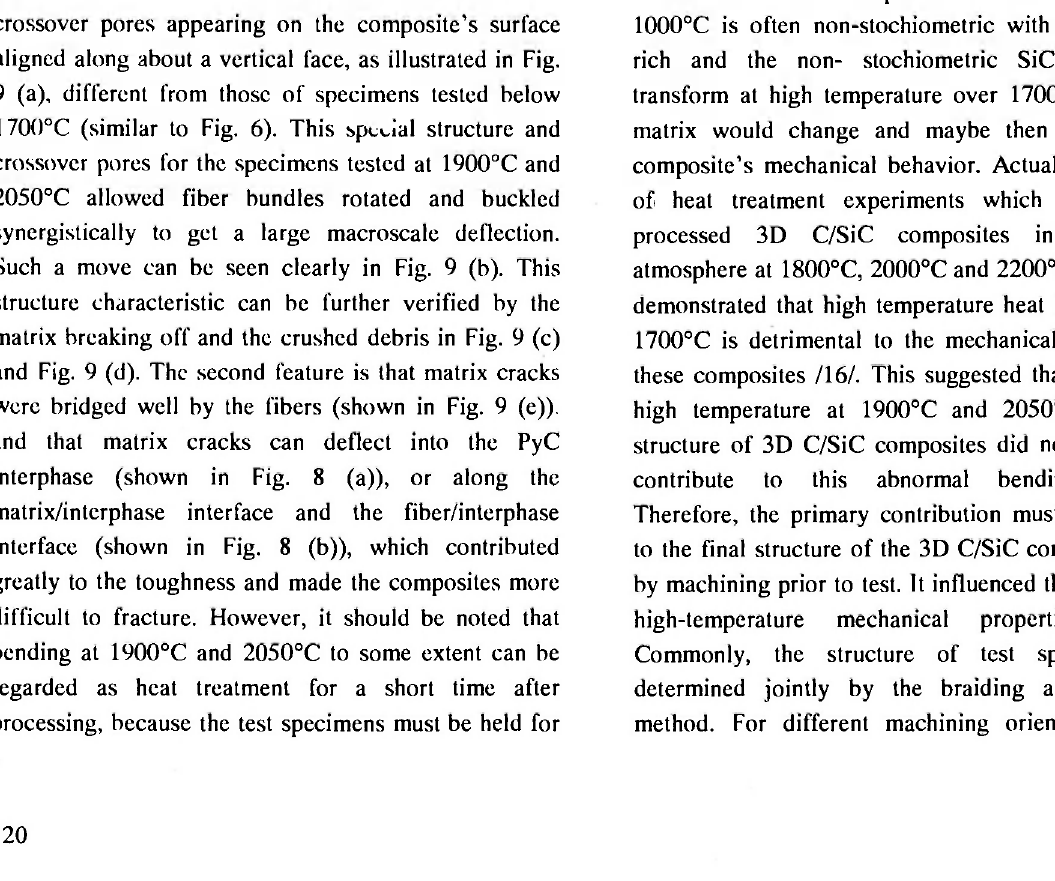
Fig. 9. SEM micrographs of the lateral surface of 3D C/SiC after three-point-bending test at 2050°C in